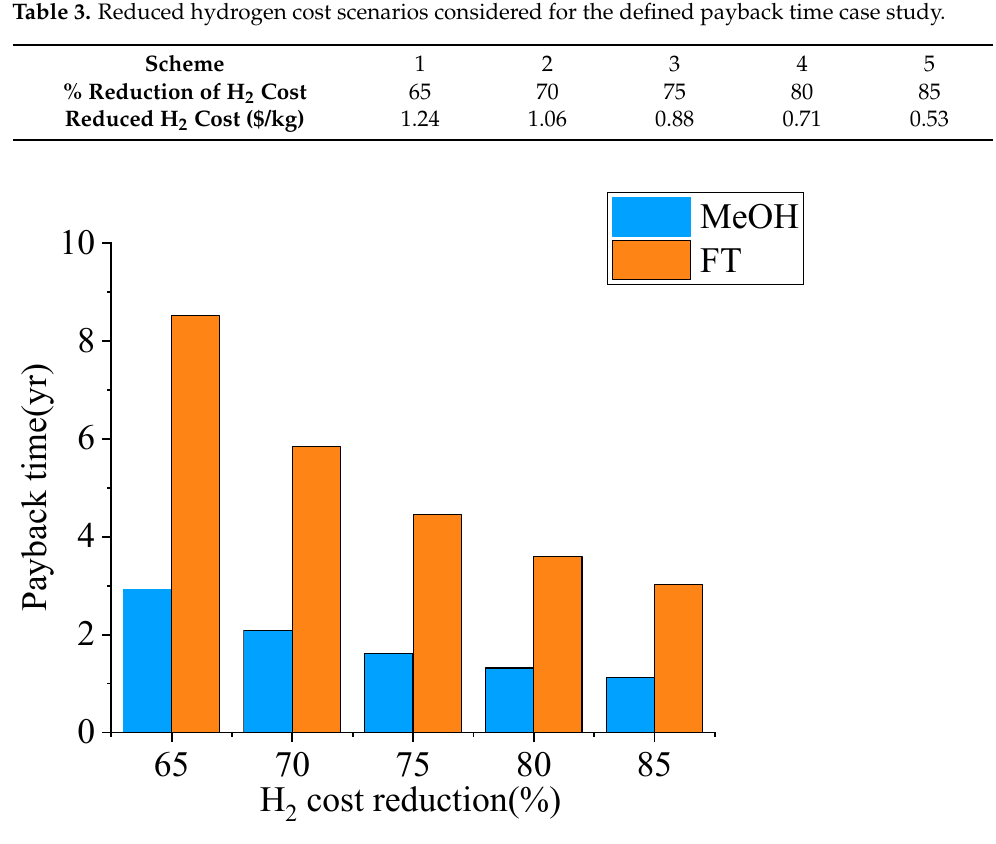
Figure 7. Payback time for both the Fischer–Tropsch process and the methanol synthesis at reduced H 2 cost scenarios (MeOH indicates the methanol synthesis process model and FT indicates the figure.